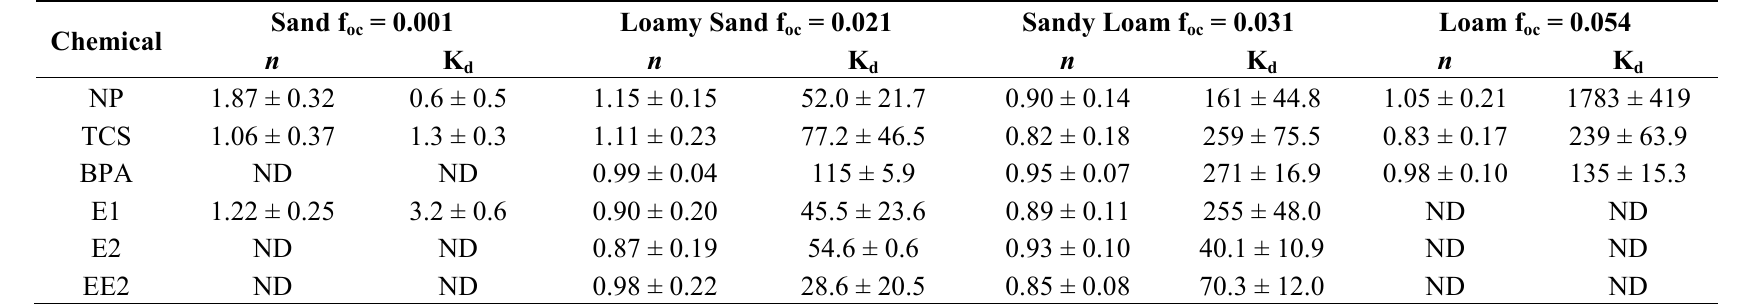
Table 4. K and n values reported ±95% CI (confidence interval) calculated from equilibrium sorption isotherm experimental results using d Equation (2). ND designates a value for which no data are available or reported due to isotherm variability.